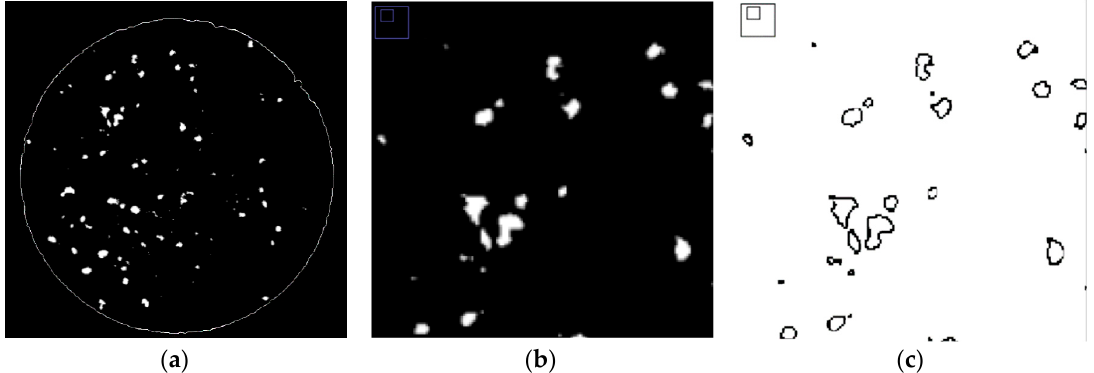
Figure 10. Selection of the calculated objects: ( a ) subtraction of image (threshold of 0:181); ( b ) selection of research objects; ( c ) reverse selection of research objects.